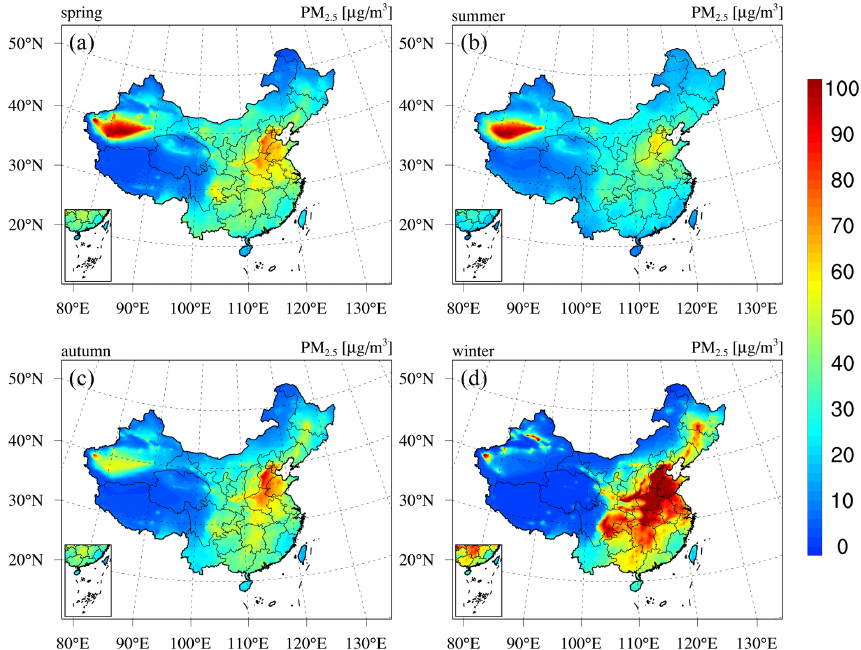
Figure D1. Spatial distributions of the PM 2 . 5 reanalysis in China during (a) spring, (b) summer, (c) autumn, and (d) winter averaged from 2013 to